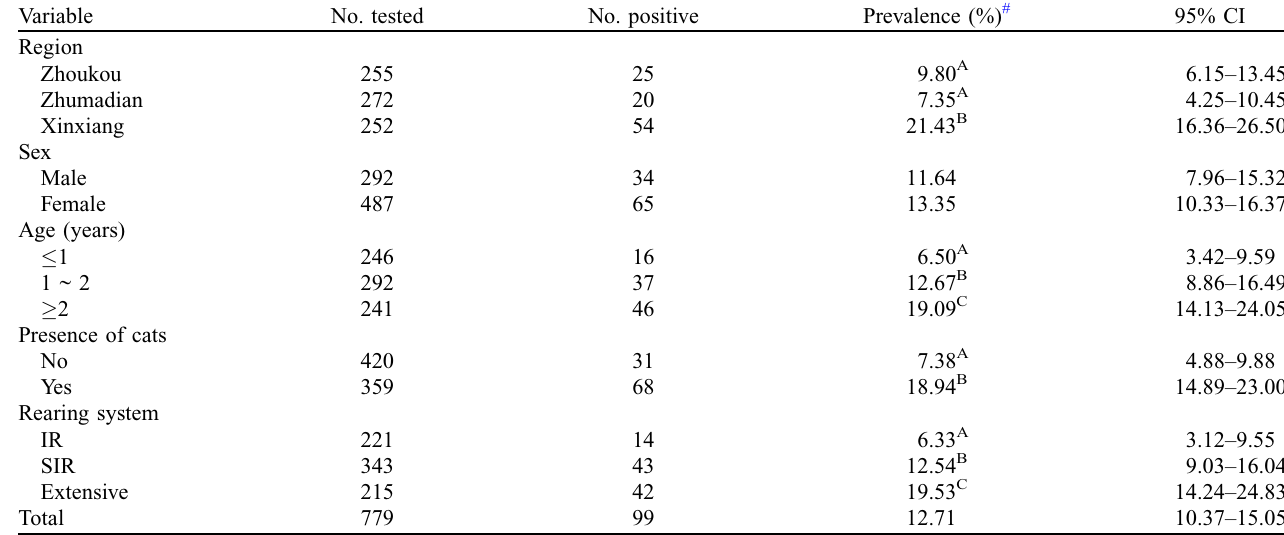
Table 2. Toxoplasma gondii infection in 779 sheep in Henan province, central China.